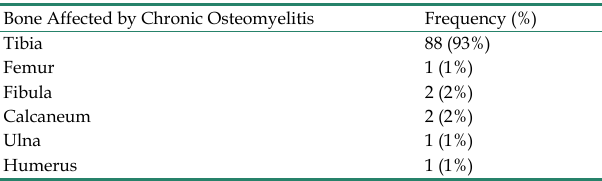
Table 3 : Osteomyelitis free flap cases by involved bone.